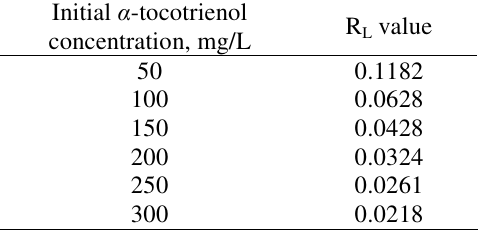
Table 2. R values based on the Langmuir equation L Initial α